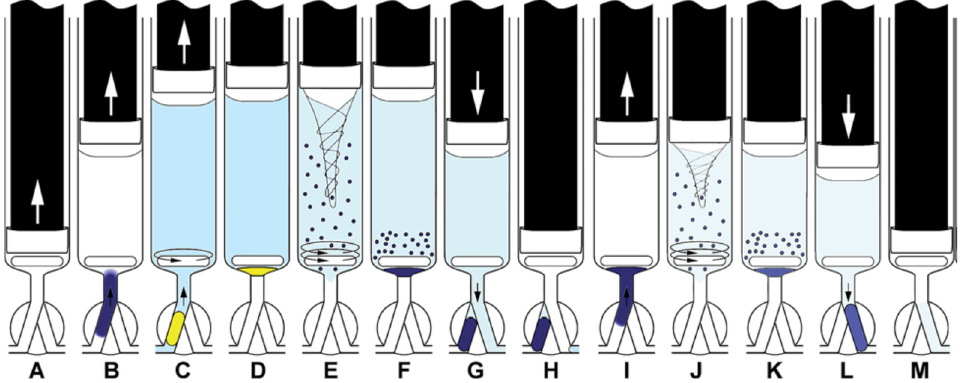
Figure 7. Operation scheme of extraction with simple extract washing. Aspiration of the sample, buffer, and DSB ( A ) and ( B ), mixing ( C ) and aspiration of the extracting solvent (ExtrS) and air ( D ), MSA ‐ DLLME. ( E ). Sedimentation of ExtrS ( F ), saving ExtrS in HC and discharge of the aqueous phase to waste ( G , H ), aspiration of DSB, barium acetate, and water ( I ), washing of ExtrS by MSA ‐ DLLME ( J ), sedimentation of ExtrS ( K ), propelling ExtrS to detector ( L ), syringe content discharge to waste ( M ) [37]. ↑ ↓ dispense.